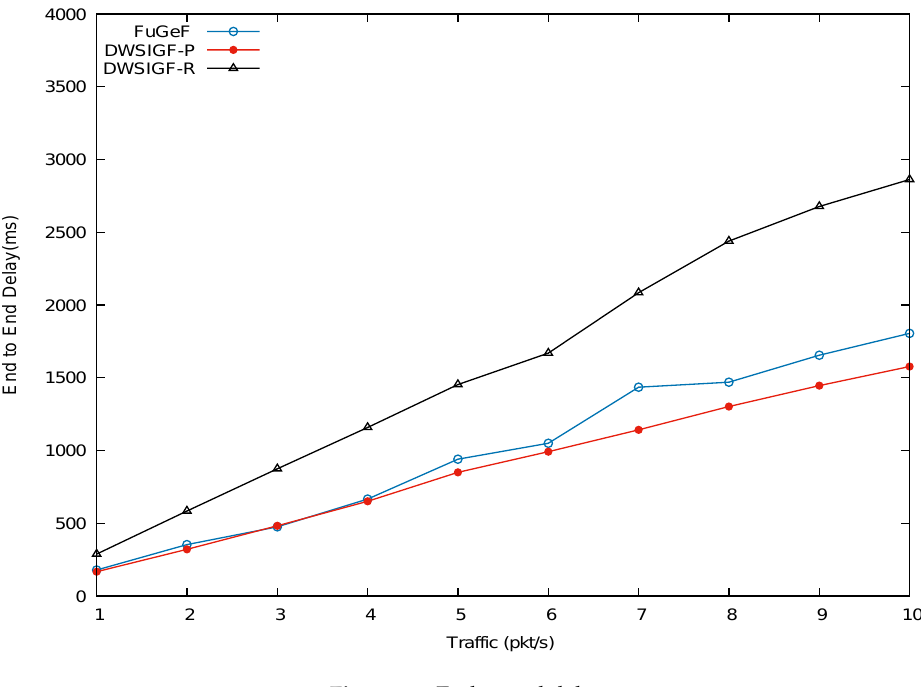
Figure 11. End to end